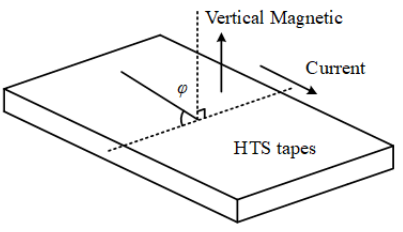
Figure 2. Magnetic field on the surface of superconducting tape.